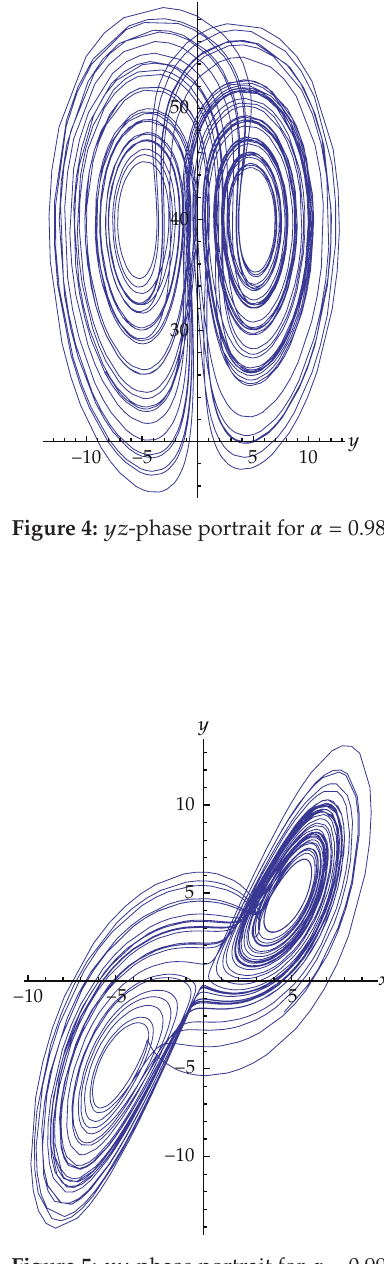
Figure 5: xy -phase portrait for α (cid:8) 0 .